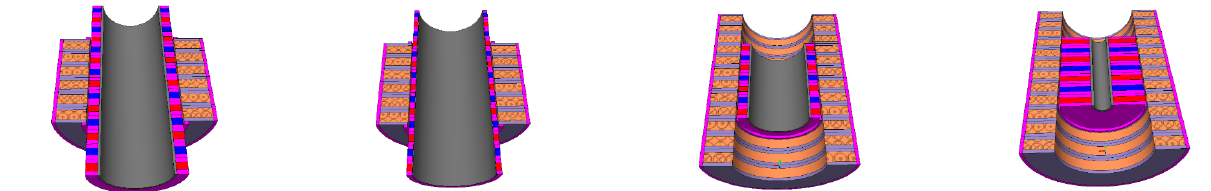
Figure 5. Linear electrical machines, ( a ) long translator (reference design), ( b ) long translator (same stator and halved the mass of translator in reference design), ( c ) short translator (doubled the stator and halved the translator of reference design), ( d ) short translator (doubled the stator and halved the translator of reference design with same mass of the translator in reference design).